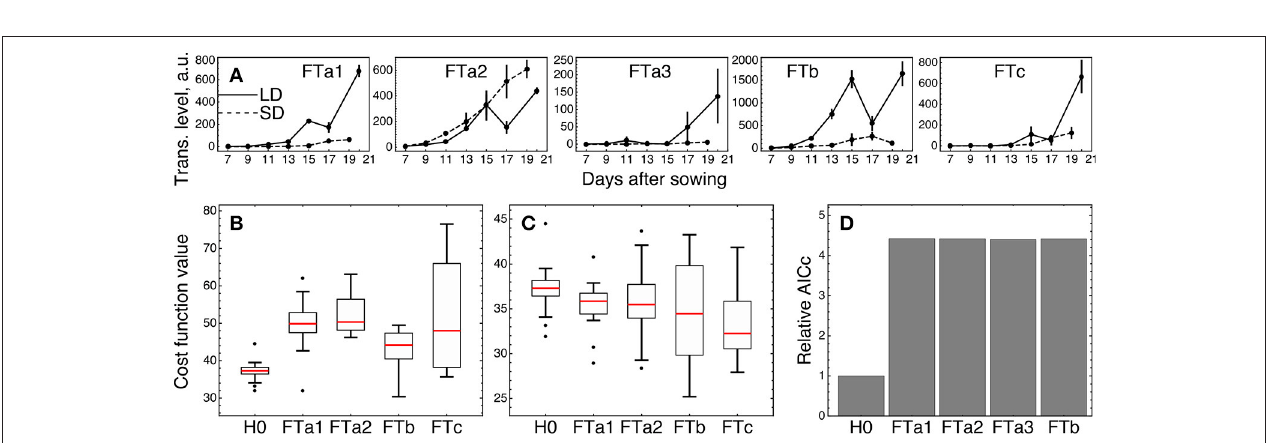
FIGURE 5 | Integral expression levels of TFL1a and TFL1c under two growth conditions in two cultivars, based on the data from (Ridge et al., 2017). The integral expression levels were calculated as described in Figure 3 .